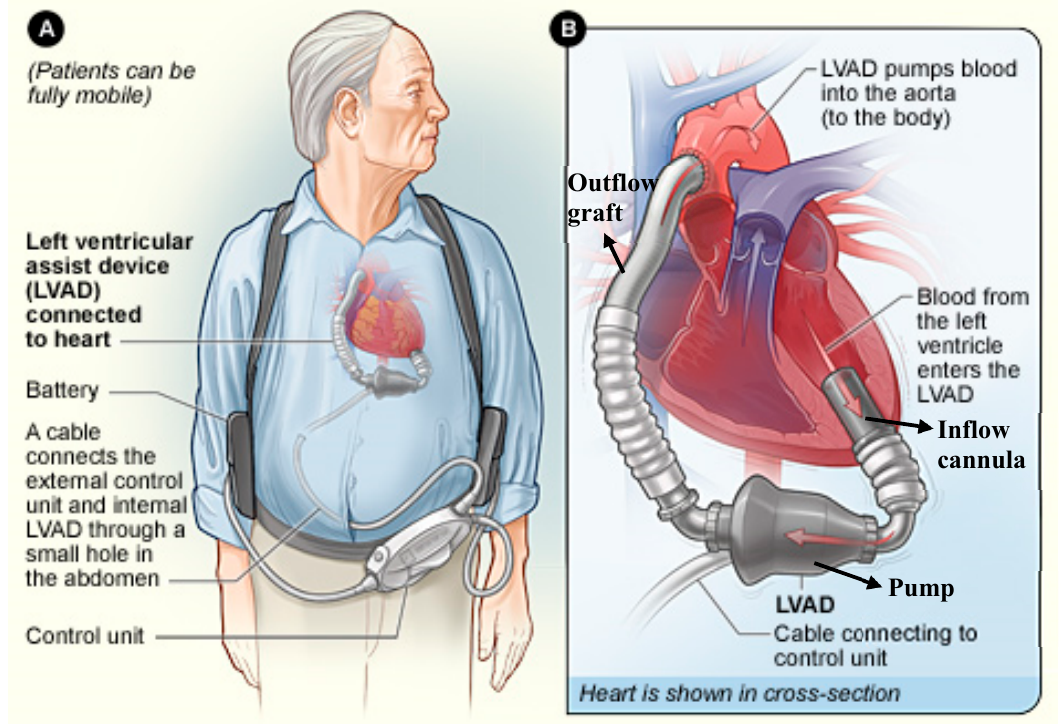
Figure 1. Components of a left ventricular assist device system. ( A ): Representation of a patient with an LVAD depicting its various external components. ( B ): Inset showing the heart in cross-section with the internal components and connections of an LVAD.